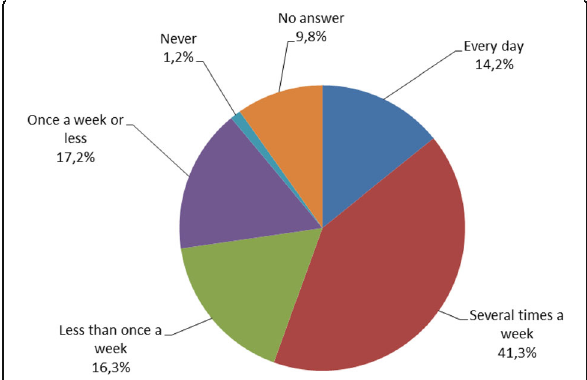
Fig. 8 The percentage division of children depending on the frequency of their consumption of salty snacks or